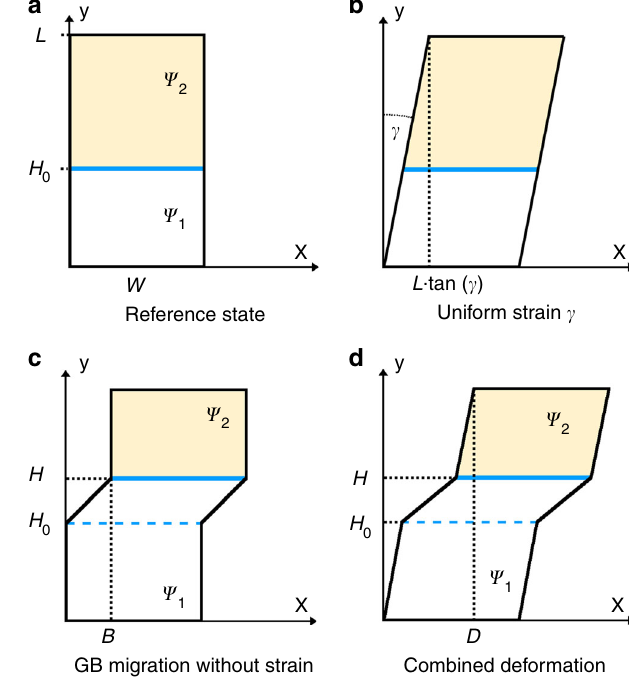
Fig. 8 Schematic represenation of the elastic model with reference con fi guration a . The total deformation can be separated into the elastic component b and the plastic component c . The total deformation is depicted in d . Fig. 7 Mode-switching in a symmetric tilt GB with fi xed ends. a – e Time (cid:2) (cid:3) sequence of a Σ 13 [111] 341 symmetric tilt GB under the same constraint conditions as Fig. 6. The temperature was 600K and the driving force was 13.8 meVÅ − 3 . Unlike Fig. 6, the GB does not stagnate, but instead continues migrating. The zig-zag pattern in the fi ducial mark indicates repeated changes in shear-coupling mode. f GB position and shear stress τ vs. time for this simulation, indicating continuous GB migration and oscillating stress. Alphabetical labeling in f indicates the corresponding time in a –